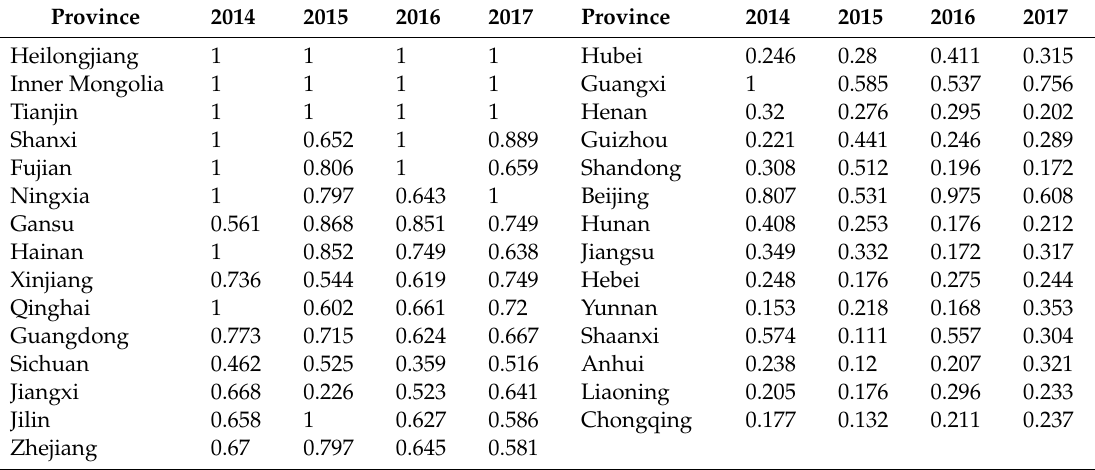
Table 3. Overall e ffi ciency for each province, from 2014 to